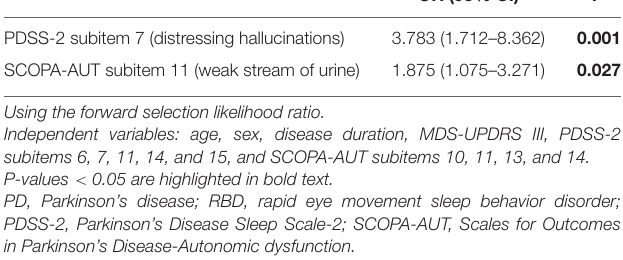
TABLE 5 | Binary logistic regression analysis of clinical variables predictive of probable RBD in PD